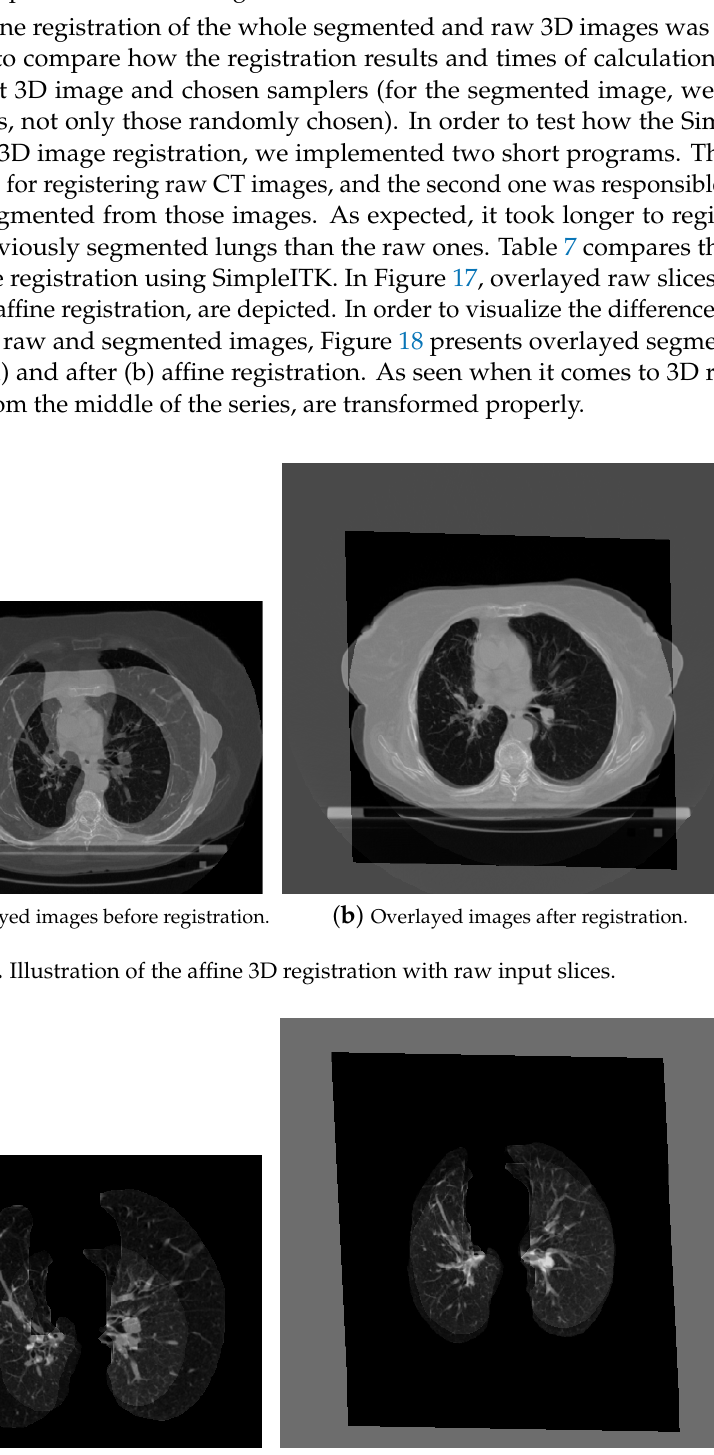
( a ) Overlayed images before registration. Figure 18. Illustration of the affine 3D registration with segmented input